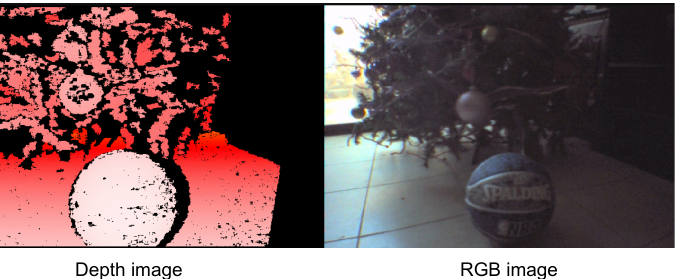
Figure 2. In the figure at the left , there is an example of a depth image representation in red tones, closer objects appear in light red, and farther objects are in darker red. The RGB camera component takes the corresponding color image of the same scene shown on the right